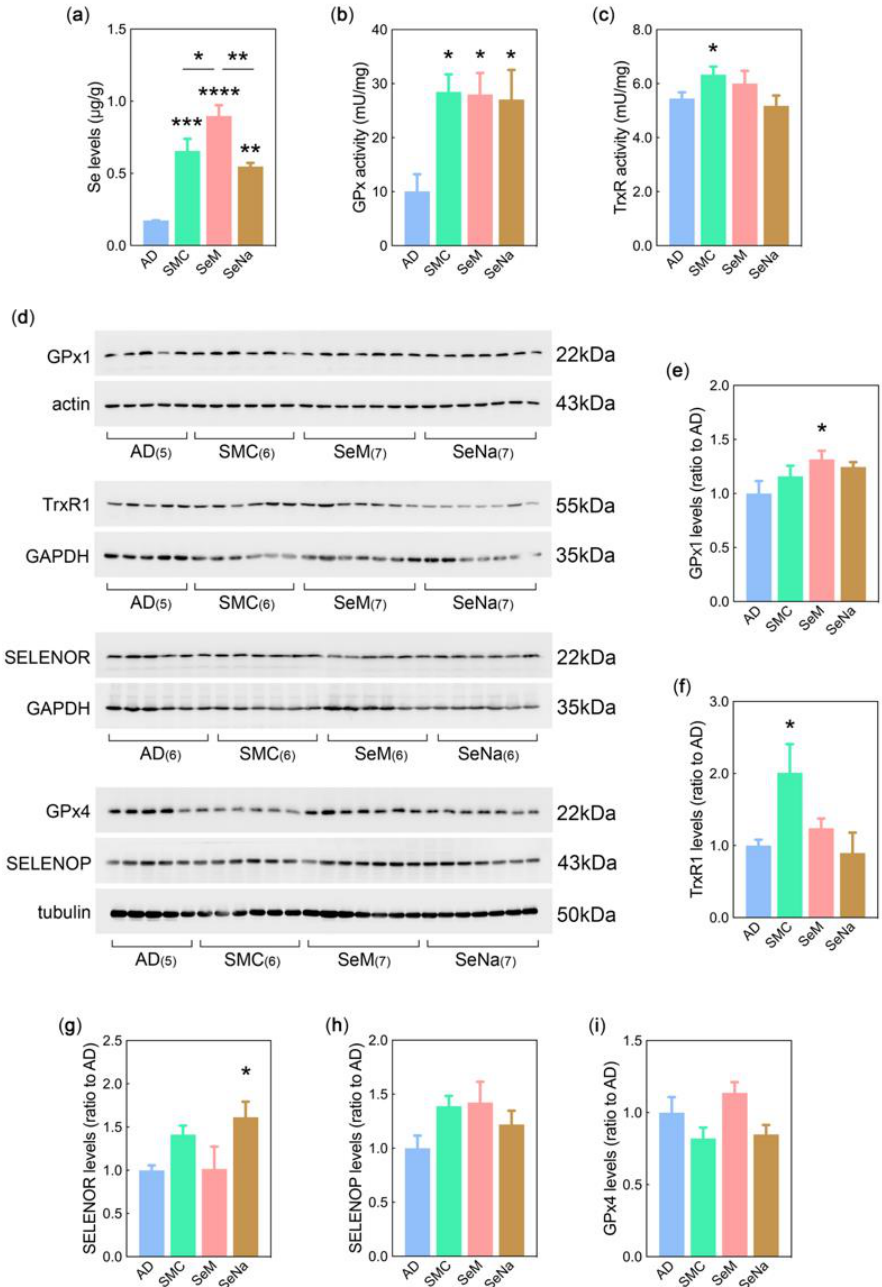
Figure 3. Increases in Se levels, selenoenzyme activity, and selenoprotein expression in the cortexes of 3 × Tg-AD mouse brains upon SMC, SeM, and SeNa administration. ( a ) Levels of Se were measured by ICP-MS ( n = 3–4). ( b , c ) Activities of GPx ( b ) and TrxR ( c ) were detected using specific assay kits ( n = 5–7). ( d ) Levels of GPx1, TrxR1, SELENOR, SELENOP, and GPx4 proteins were analyzed by Western blotting ( n = 5–7). ( e – i ) Quantification of protein levels in ( d ). α -Tubulin, β -actin, or GAPDH were used as loading controls. All data are presented as the means ± SEMs. * p < 0.05, ** p < 0.01, *** p < 0.001, **** p < 0.0001 vs. AD mice, as determined by one-way ANOVA followed by Dunnett’s multiple comparison